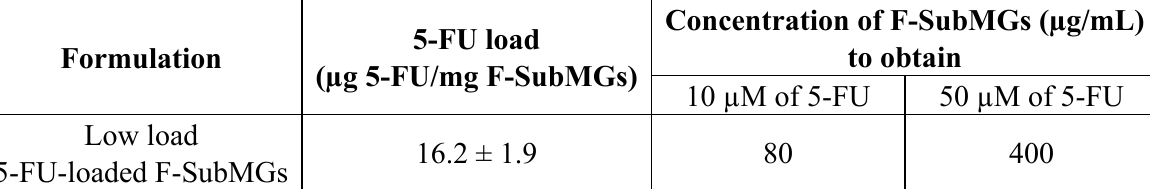
Table 2. Concentration of F-SubMGs needed to obtain 10 µM and 50 µM of 5-FU in the cell culture